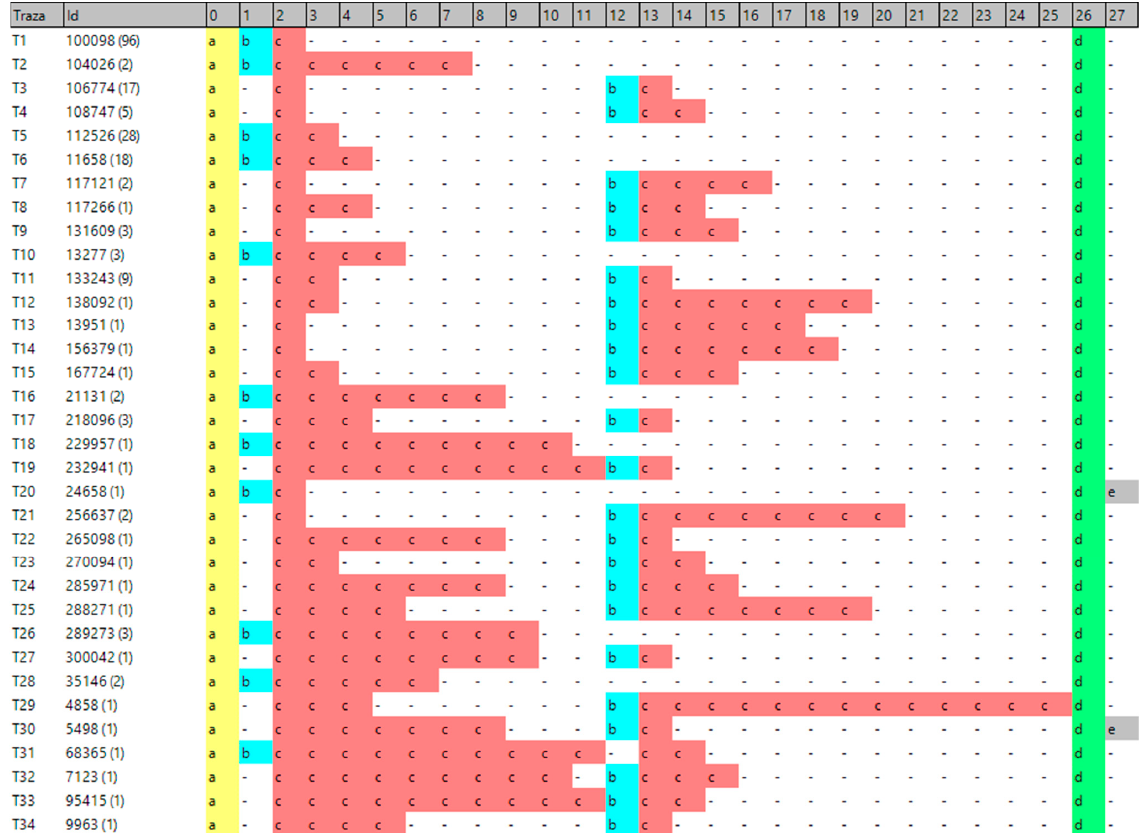
Figure 12. View of the sequences of activities with product eliminations after printing. Annulled checks without prior suppression of the inserted products.